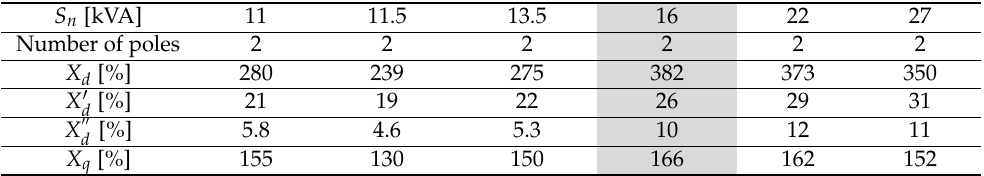
Table 2. Two-pole synchronous generator data with a rated voltage of 400 V from Linz Electric company [24].